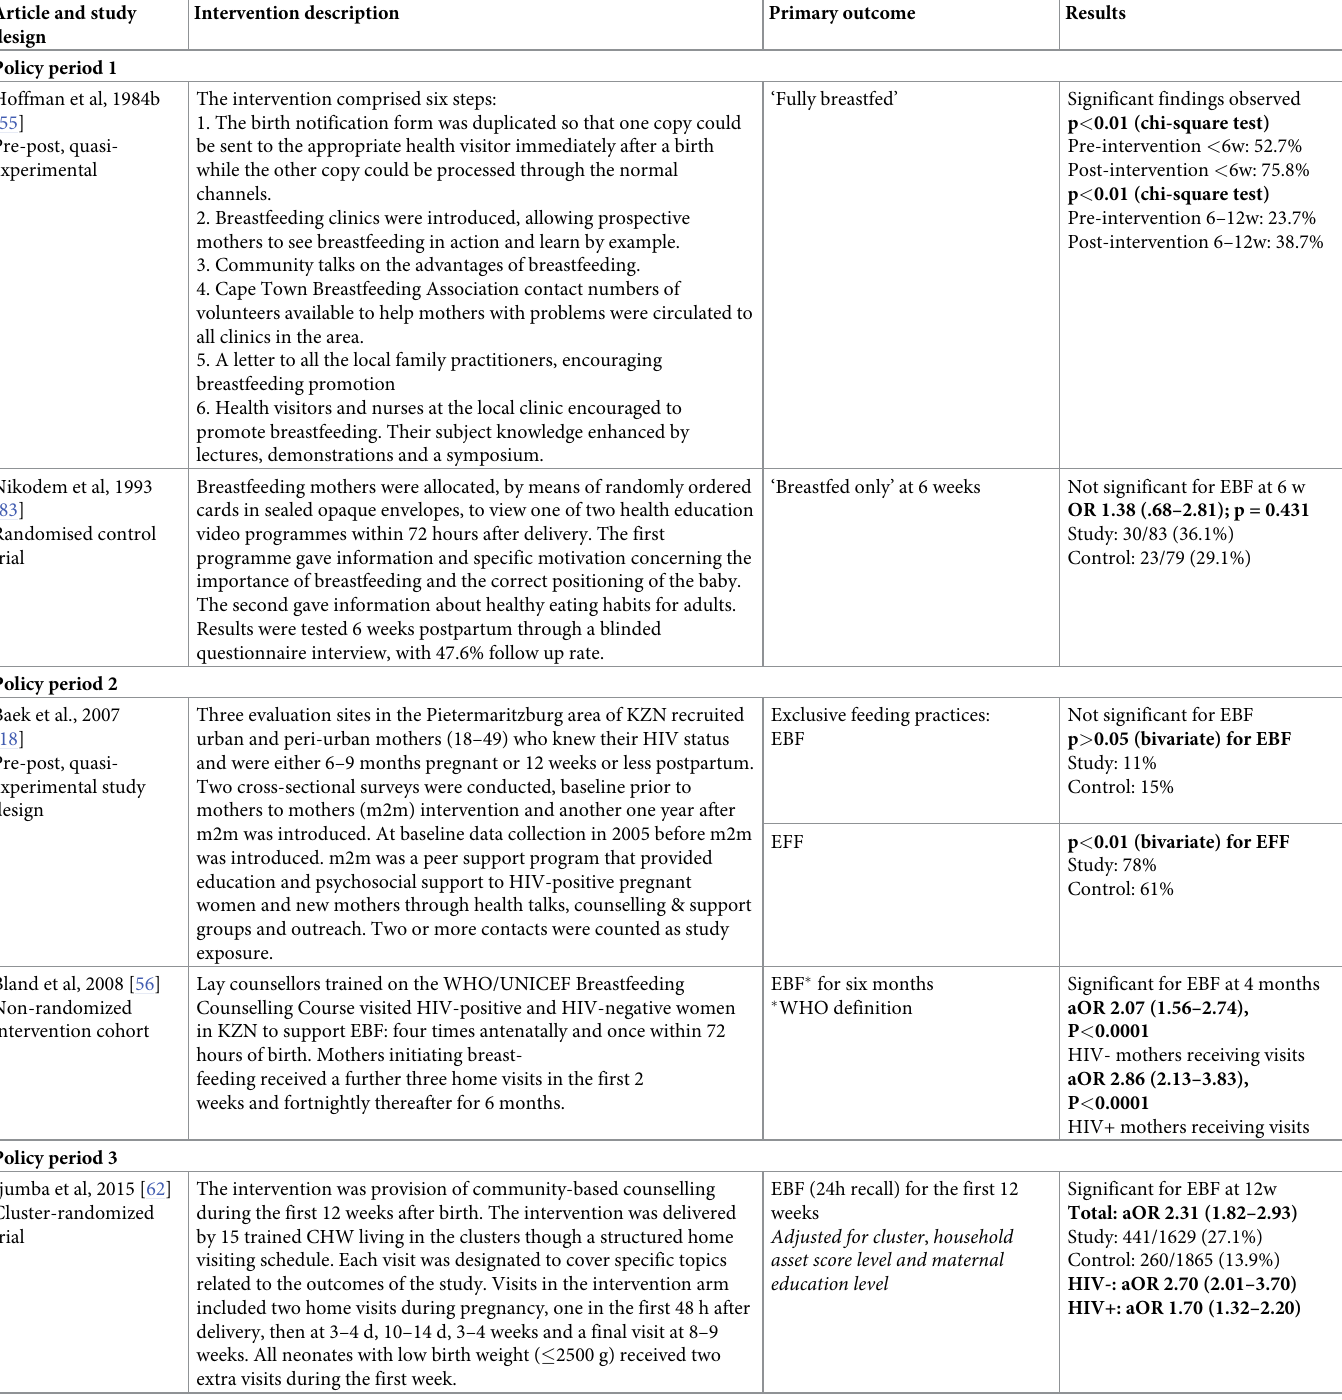
Table 4. EBF promotion intervention